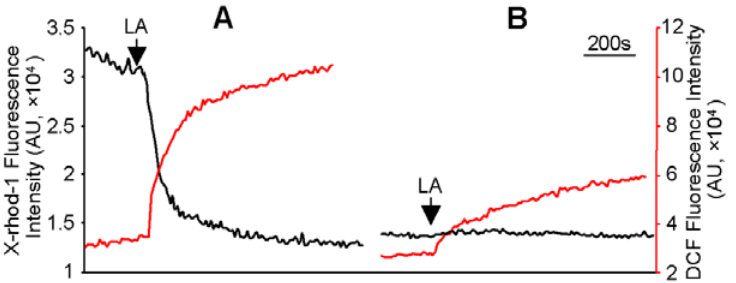
Figure 4. LA-induced mitochondrial Ca 2 + efflux was responsible for peroxynitrite generation. Mitochondria were prepared from HM cells and labeled with X-rhod-1 (2 m M) and DCF (1 m M) with (A) or without Ca 2 + (B). LA-induced mitochondrial Ca 2 + efflux (black traces) and peroxynitrite generation (red traces) were indexed by the gradual decrease in X-rhod-1 and increase in DCF fluorescence intensity, respectively.